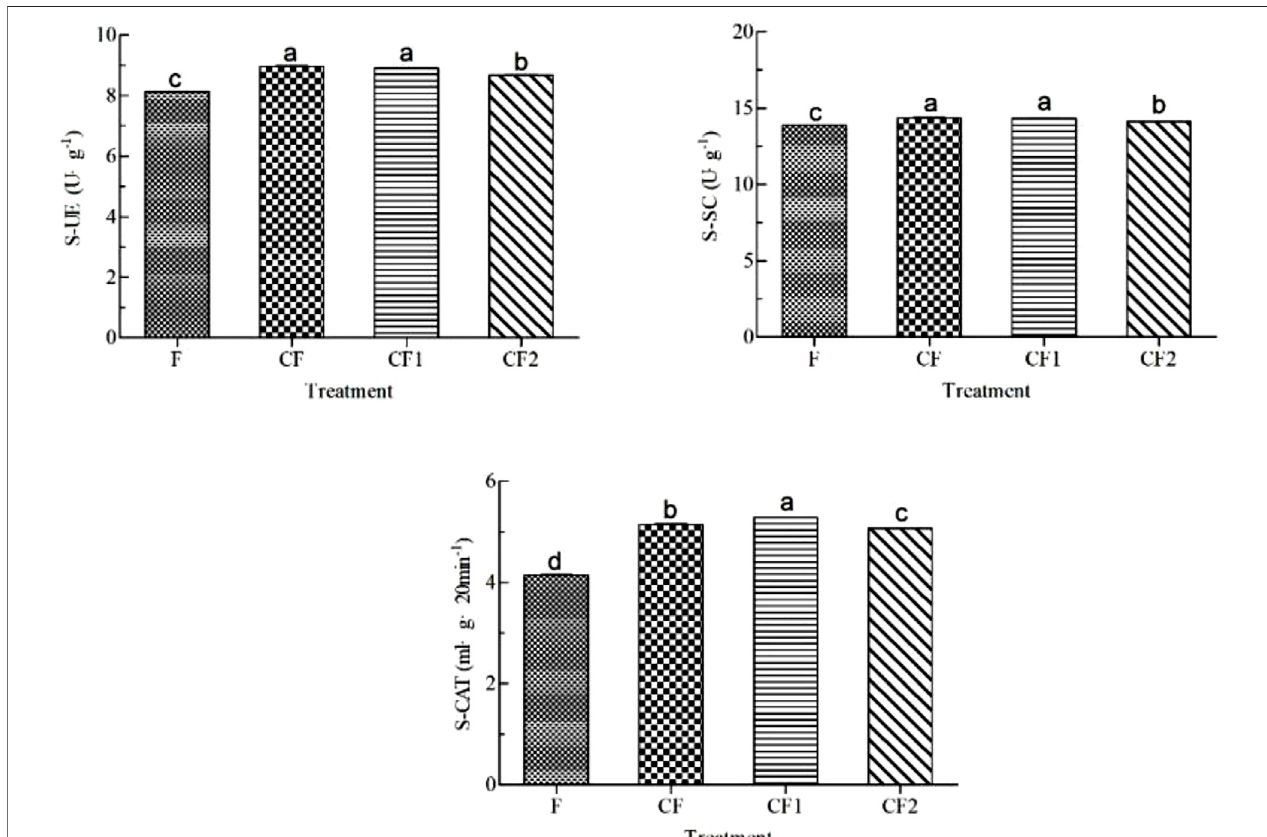
Frontiers in Environmental Science |